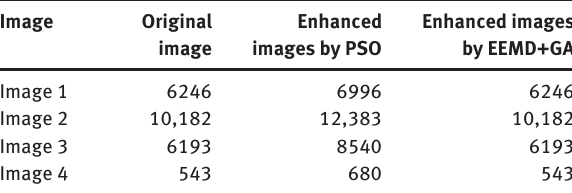
Table 3. Number of Edges Detected Using Sobel Edge Detector for the Four Test